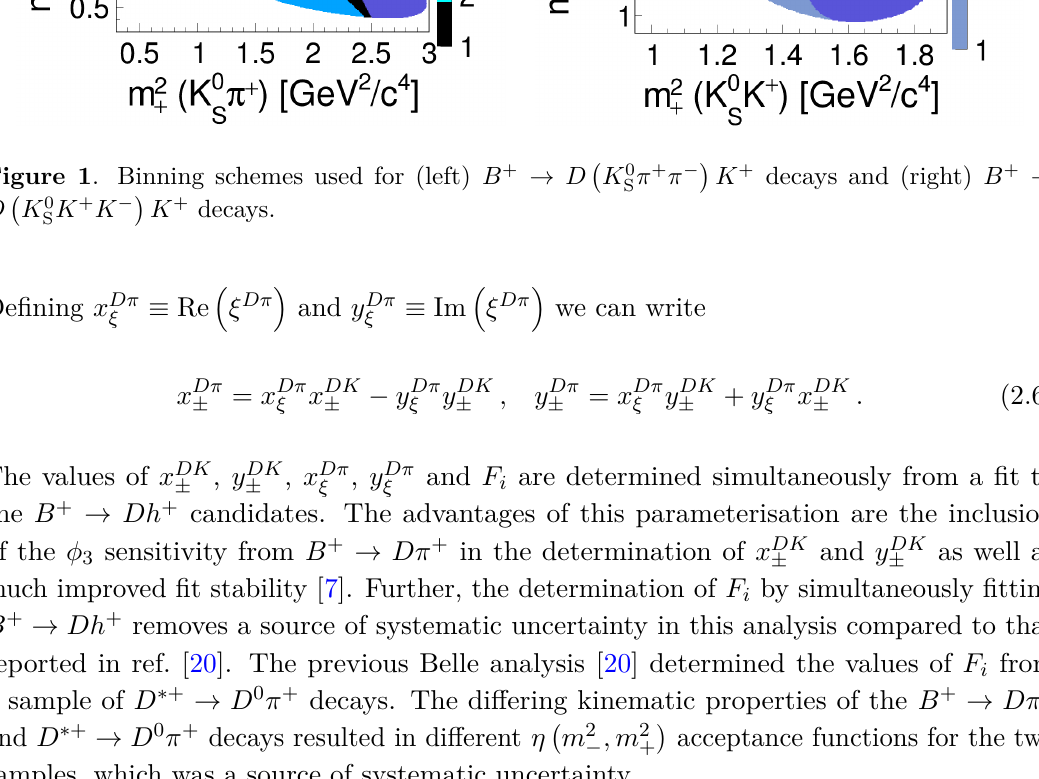
(cid:0) (cid:1) K 0 π + π − K + decays and (right) B + → S